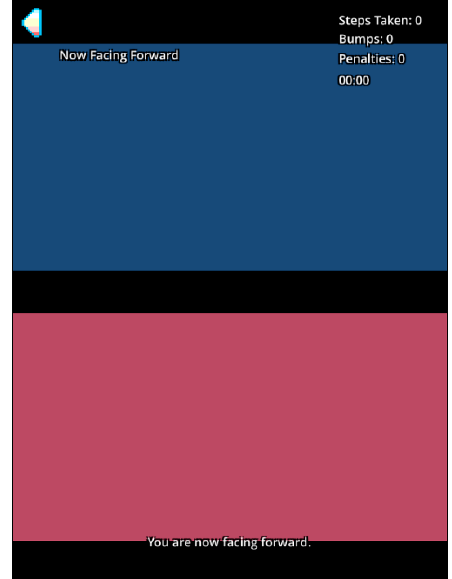
Figure 3. Screenshot of game level with blind mode on.